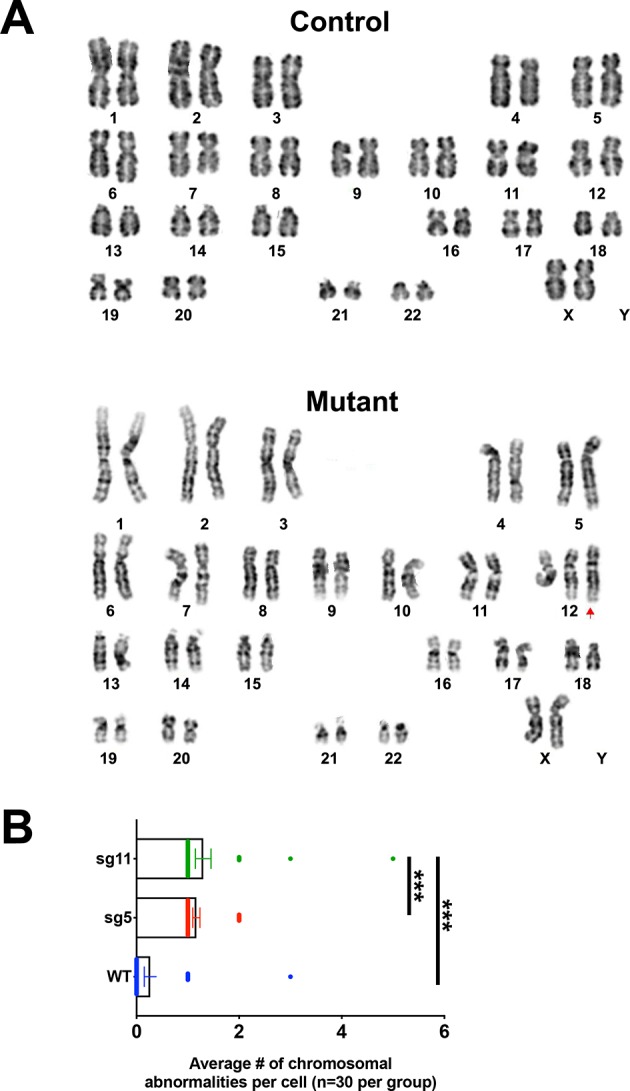
Mutant hESC-derived cortical organoid neural progenitors exhibit increased aneuploidy.(A) Representative image of G-banded karyotype analysis of WT, sg5, and sg11 metaphase cells isolated from d20 cortical organoids. (B) Quantification of average number of chromosomal abnormalities found per analyzed cell. n = 30 cells per group. One-way ANOVA with Tukey’s multiple comparison test, ***p<0.001.